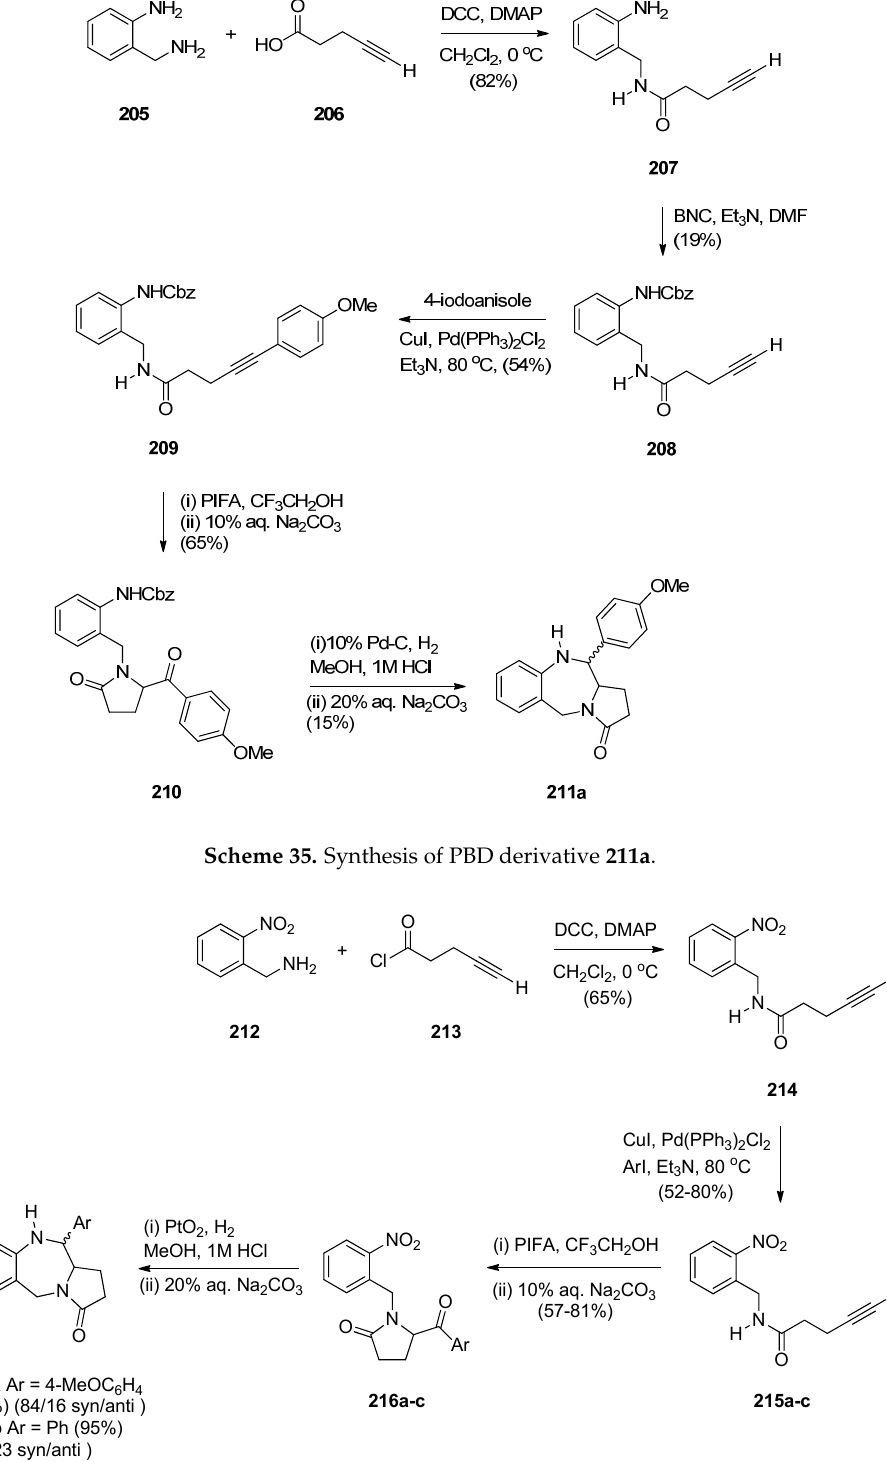
Scheme 36. Synthesis of PBD derivatives 211a – c .